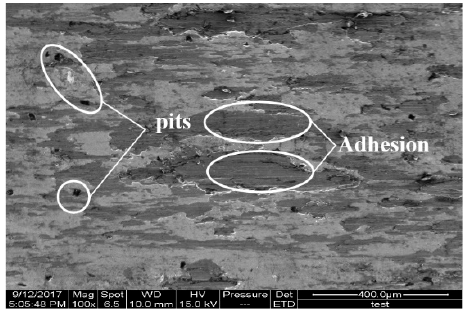
Figure 4. Smooth surface friction.